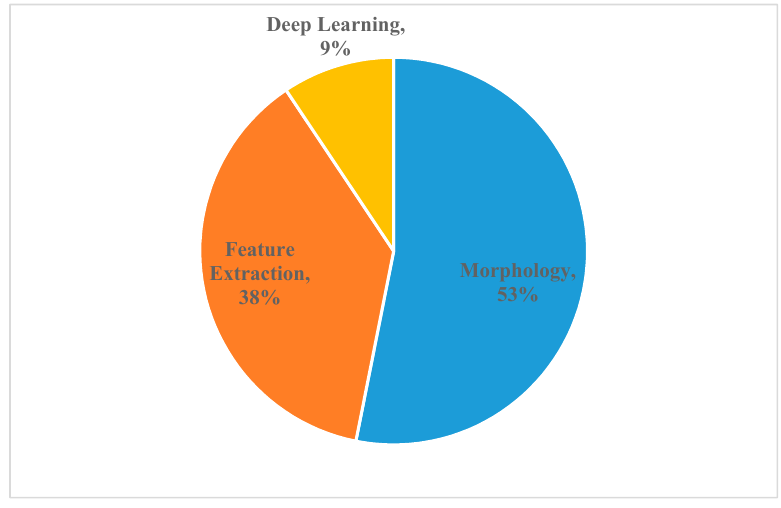
Figure 6. Number of studies using various types of computer vision techniques.